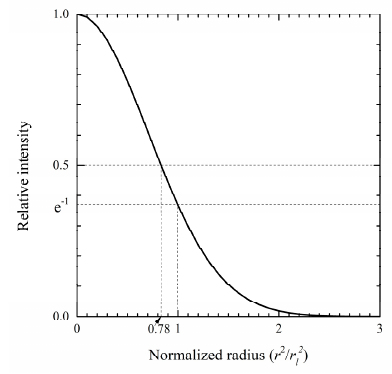
Figure 6. The radius of a Gaussian laser.